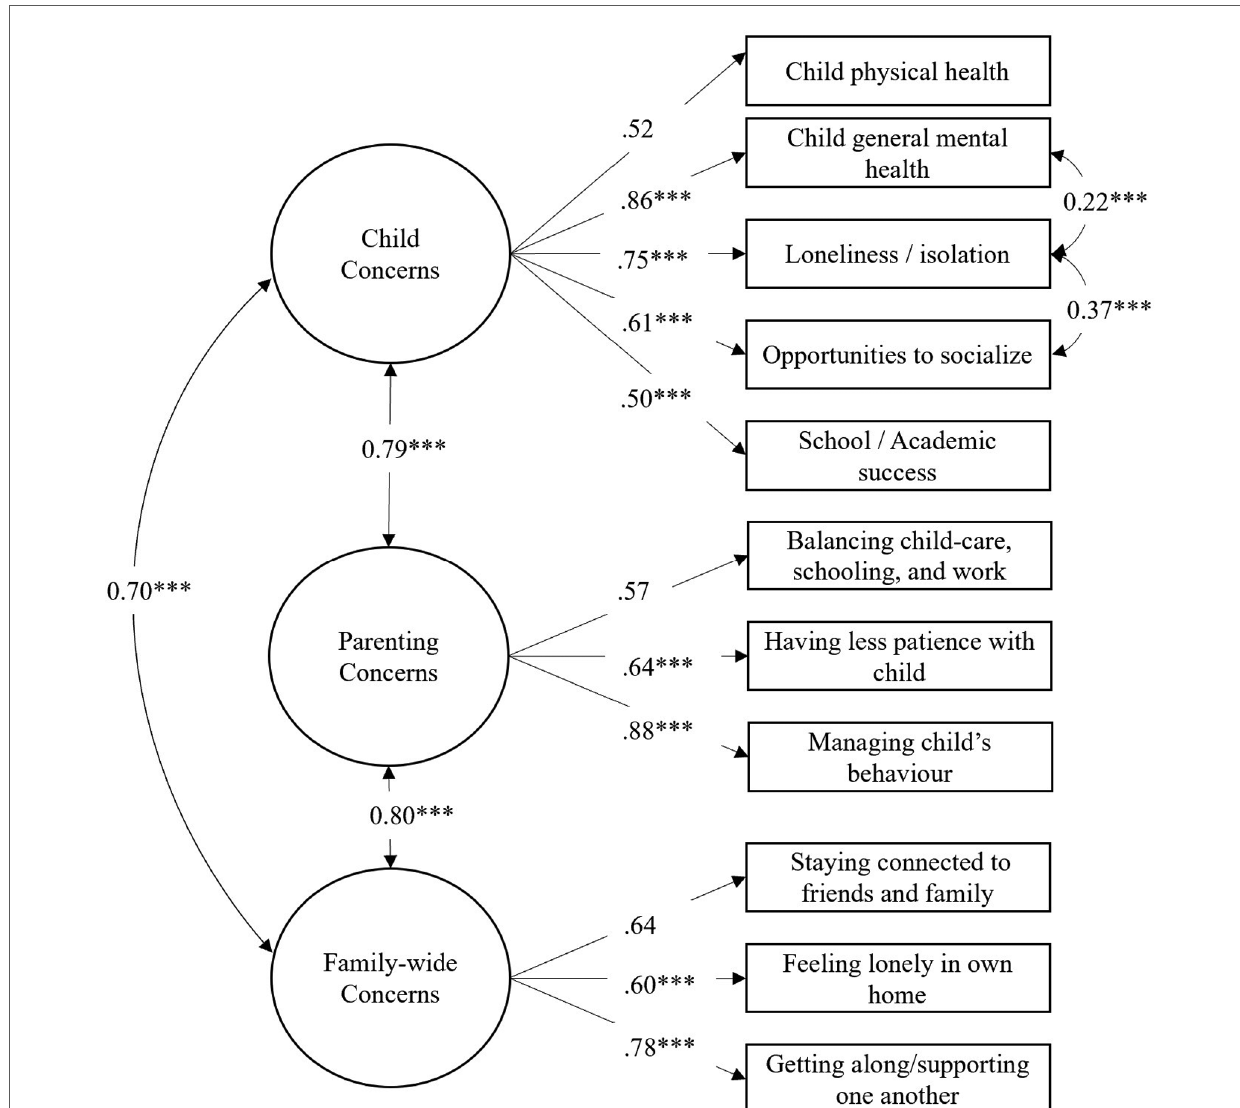
FIGURE 1 Measurement model. Circles re fl ect latent variables, boxes re fl ect factors. Double-sided arrows re fl ect correlations, single-sided arrows depict factor loadings. Standardized estimates reported, restricted sample depicted — without multivariate outliers. For each factor, the fi rst indicator was fi xed to 1.0. Within-factor correlations for the Child Concerns latent variable were added based on consideration of modi fi cation indices and theoretical justi fi cation. ***p